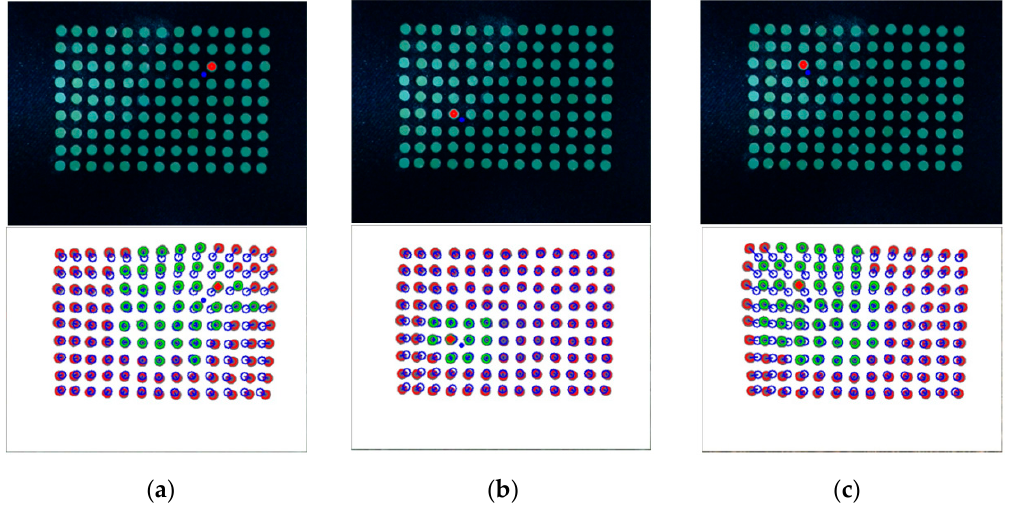
Figure 14. Contact position estimation by using a gaussian fitting process ( a ) the results of contact position estimation when pressing the upper right ( b ) the results of contact position estimation when pressing the bottom left ( c ) the results of contact position estimation when pressing the upper left.